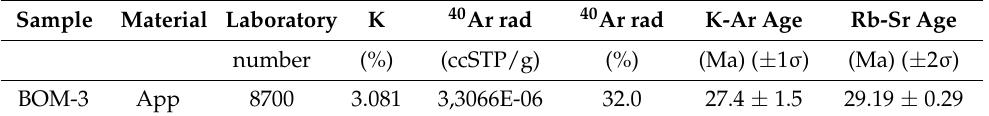
Table 3. K isotopic data apophyllite (App) from the Deccan volcanic province (India) near Mumbai. In comparison the corresponding Rb-Sr ages are given. For an explanation see